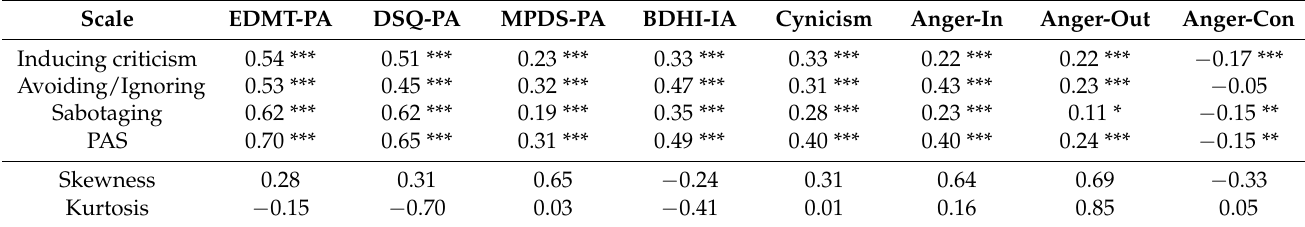
Table 4. Correlational matrix of EDMT, MPDS, DSQ, BDHI, cynicism, anger-in, anger-out, anger control, and PAS ( n =